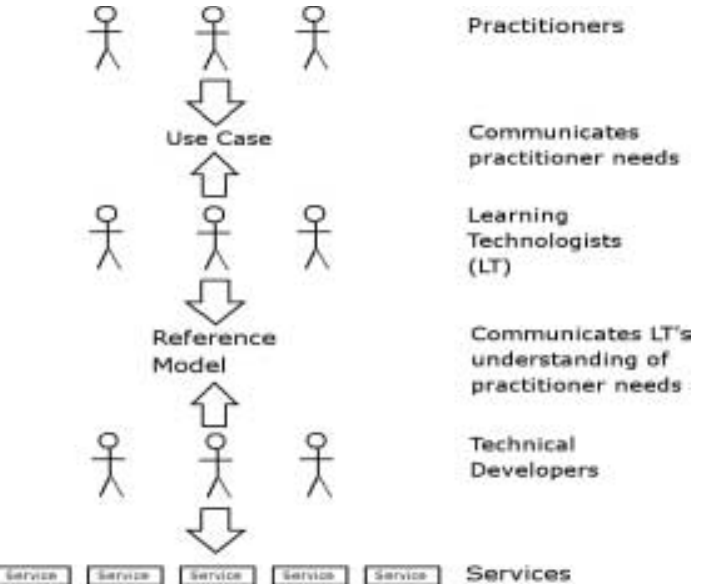
Figure 4. Communication structure and mediating representations implied by the proposed LADiE